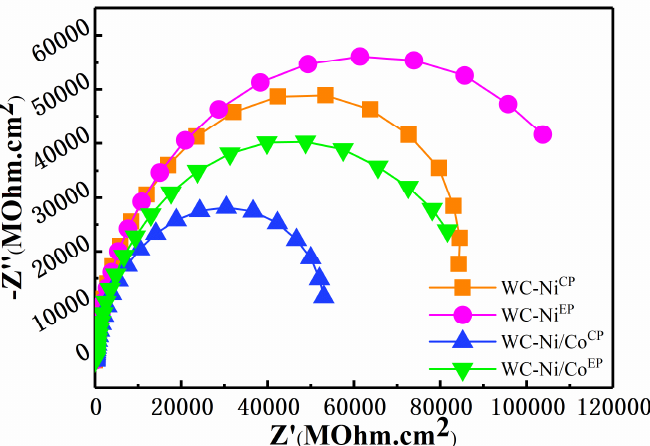
Figure 7. Impedance spectra of cemented carbide samples.